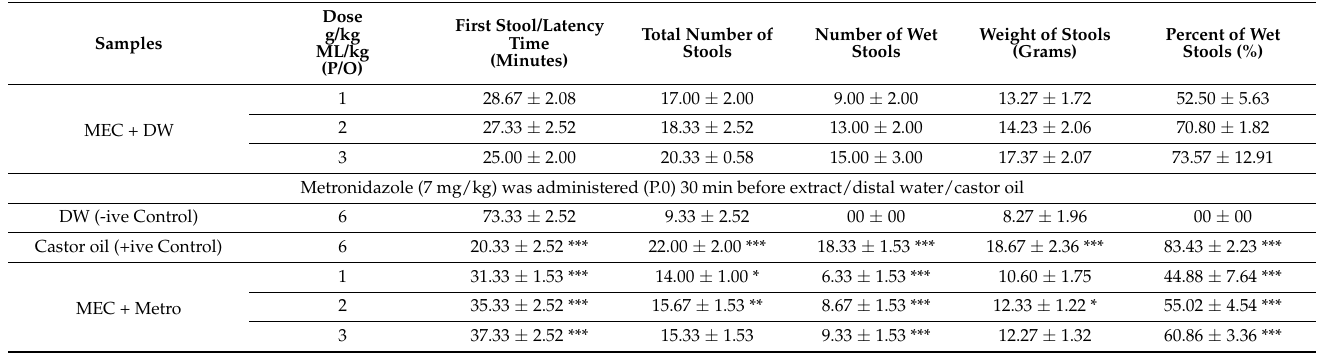
Table 5. Diarrheal/laxative activity of methanolic extract of C. tinctoria in metronidazole induced consti-pation in pigeons.